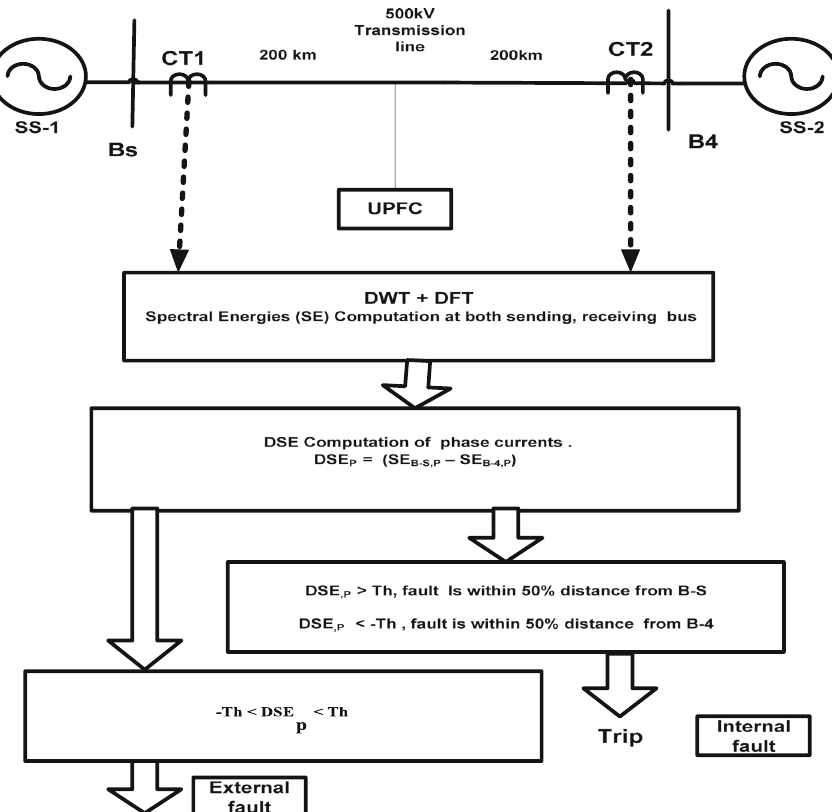
Fig. 2 Flow chart of the relaying